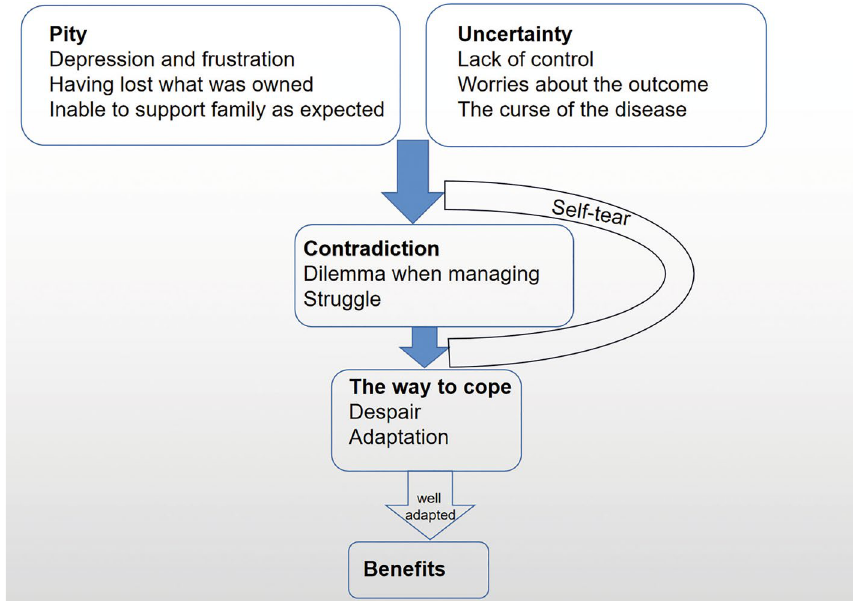
Figure 1. The process of people’s adaptation to self-management. Patients tended to experience pity and uncertainty at the beginning and as the process went on, they gradually felt contradiction. The pain promoted self-tear. During the process of self-tear, they would adapt to life in two different ways: failed to manage life well and felt despair or positively adapt to life well and get benefits. The despair might be temporary and they would adapt well finally and get benefits after proper